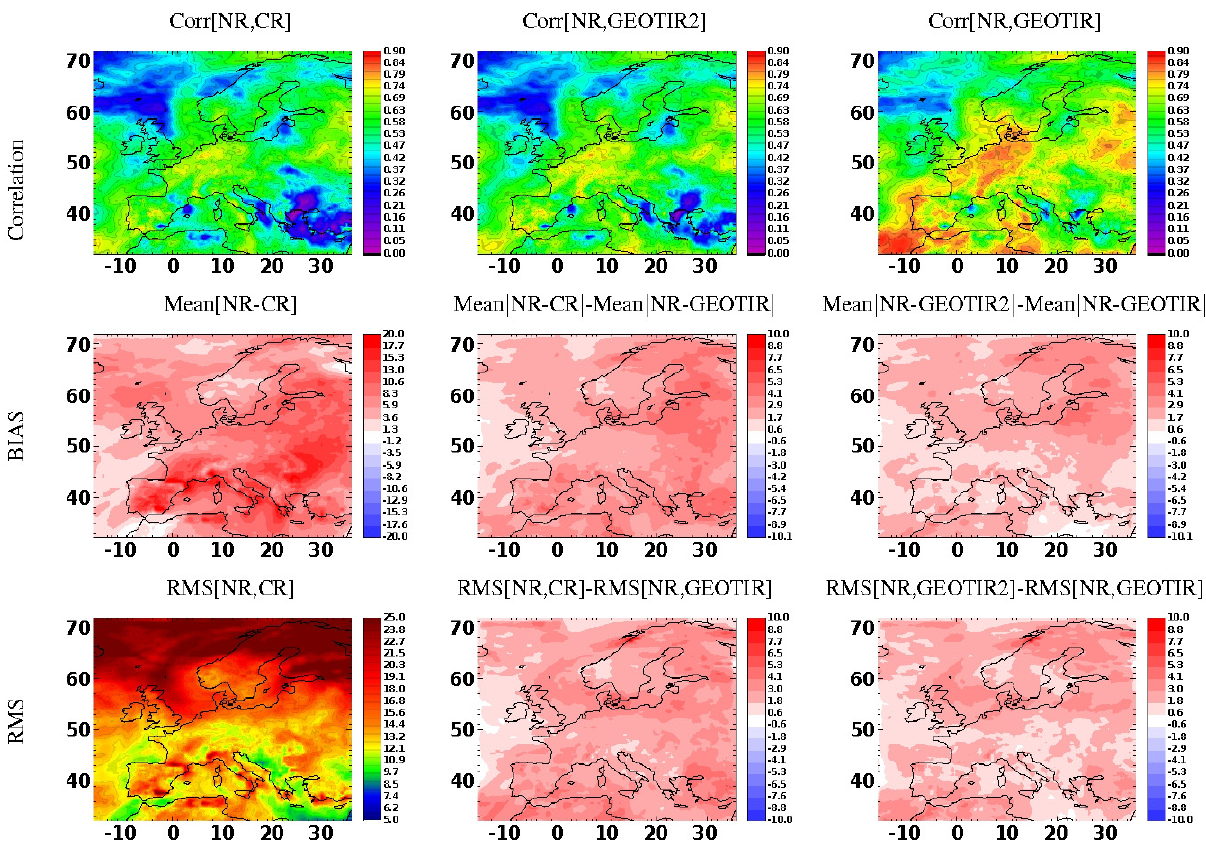
Fig. 11. Same as Fig. 5 but for the experiment with a change in the emissions, meteorology and initial condition